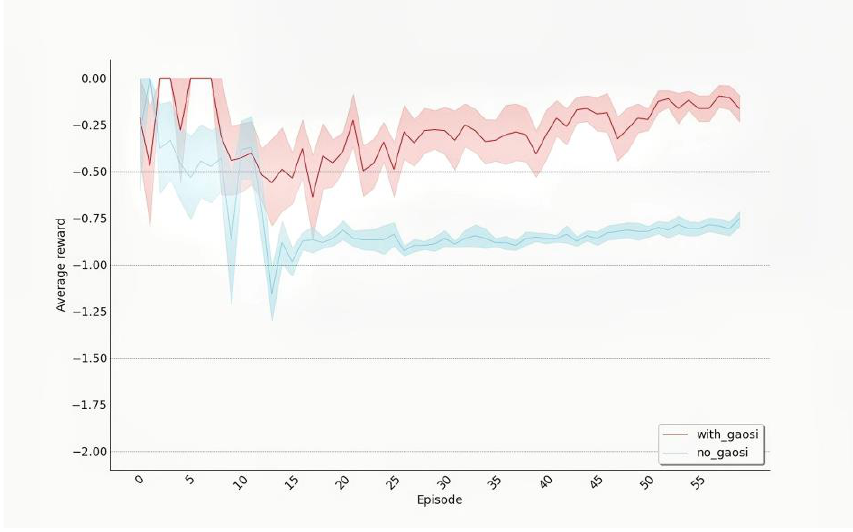
Figure 16. Reward curve of variable Gauss safety field.